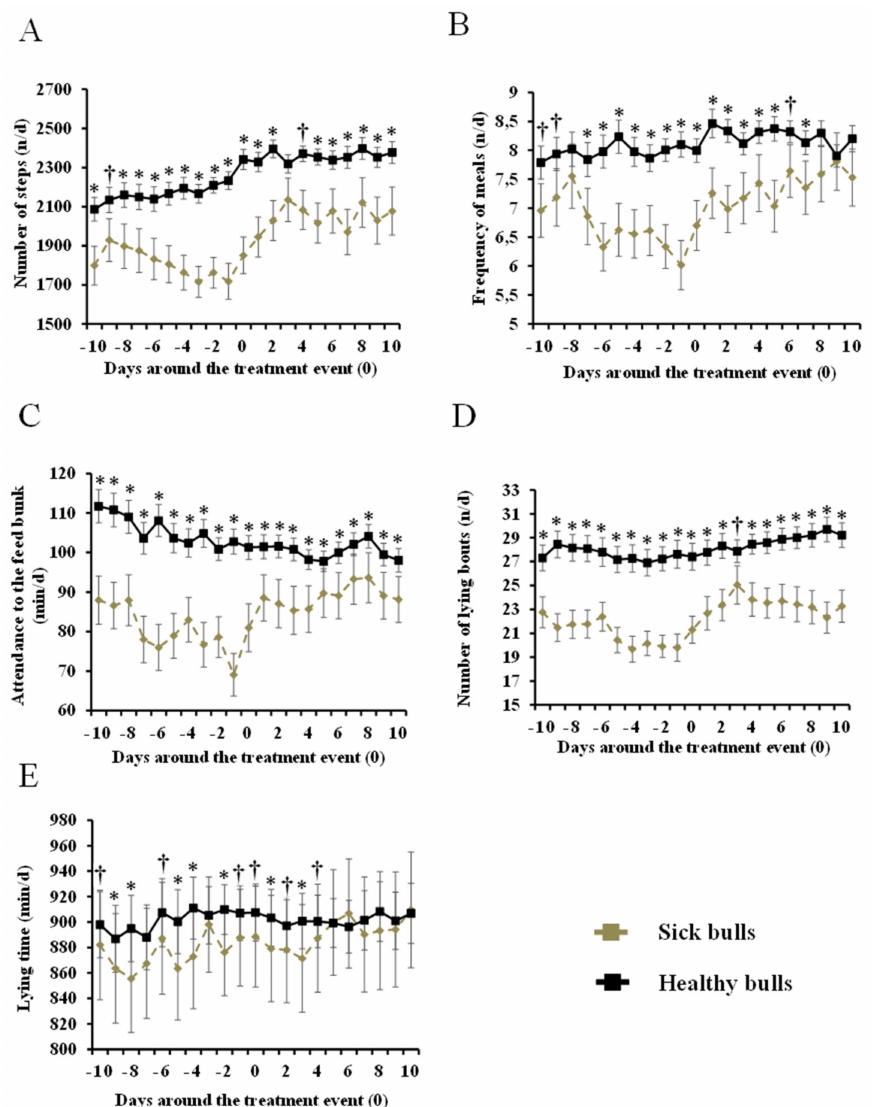
Figure 2. Daily steps counts n / day ( A ), frequency of meals at the feed bunk n / day ( B ), attendance at the feed bunk min / day ( C ), number of lying bouts n / day ( D ), and time lying min / day ( E ) for of sick bulls (n = 33) vs . matched paired healthy bulls (n = 99) from 10 days before to 10 days after the first treatment event. Means within day di ff er (*; p < 0.05) or tended to di ff er ( † ; 0.05 < p < 0.10). Di ff erences between healthy and sick bulls started to be evident from at least 10 day before the first treatment event took place. Sick bulls did in average 15% fewer steps (days: − 10, − 8, − 7, − 6, − 5, − 4, − 3, − 2, − 1, 0, + 1, + 2, + 5, + 6, + 7, + 8, + 9, and + 10; p < 0.05; − 9 and 4; p < 0.10), 22% less lying bouts (from days − 10 to + 10 except for day + 3; p < 0.05; day + 3; p < 0.10), and spent less time lying (days: − 9, − 8, − 5, − 4, − 2, + 1, and + 3; p < 0.05; − 10, − 6, − 1, 0, + 2, and + 4; p < 0.10) compared with healthy bulls. Bulls attended the feed bunk 15% fewer times (days: − 7, − 6, − 5, − 4, − 3, − 2, − 1, 0, + 1, + 2, + 3, + 4, + 5, and + 7; p < 0.05; − 10, − 9 and + 6; p < 0.10), and spent 18% less time at the feed bunk (days: from − 10 to + 10; p < 0.05) than healthy bulls. Table 1 provides the probability level for the e ff ect of health status, days of sickness, season, age, and the interaction between health status and days of sickness on all behavioral